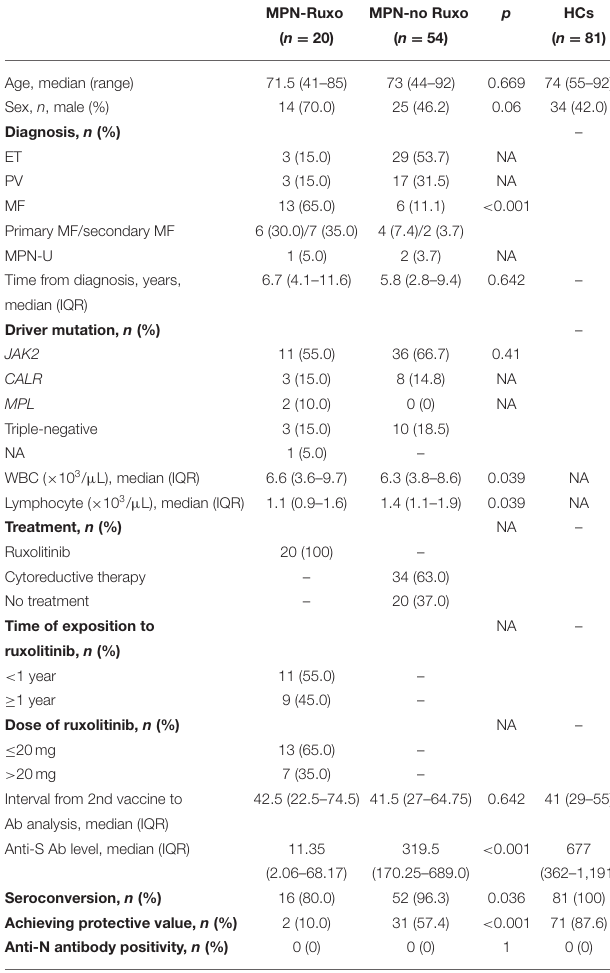
TABLE 1 | Patient